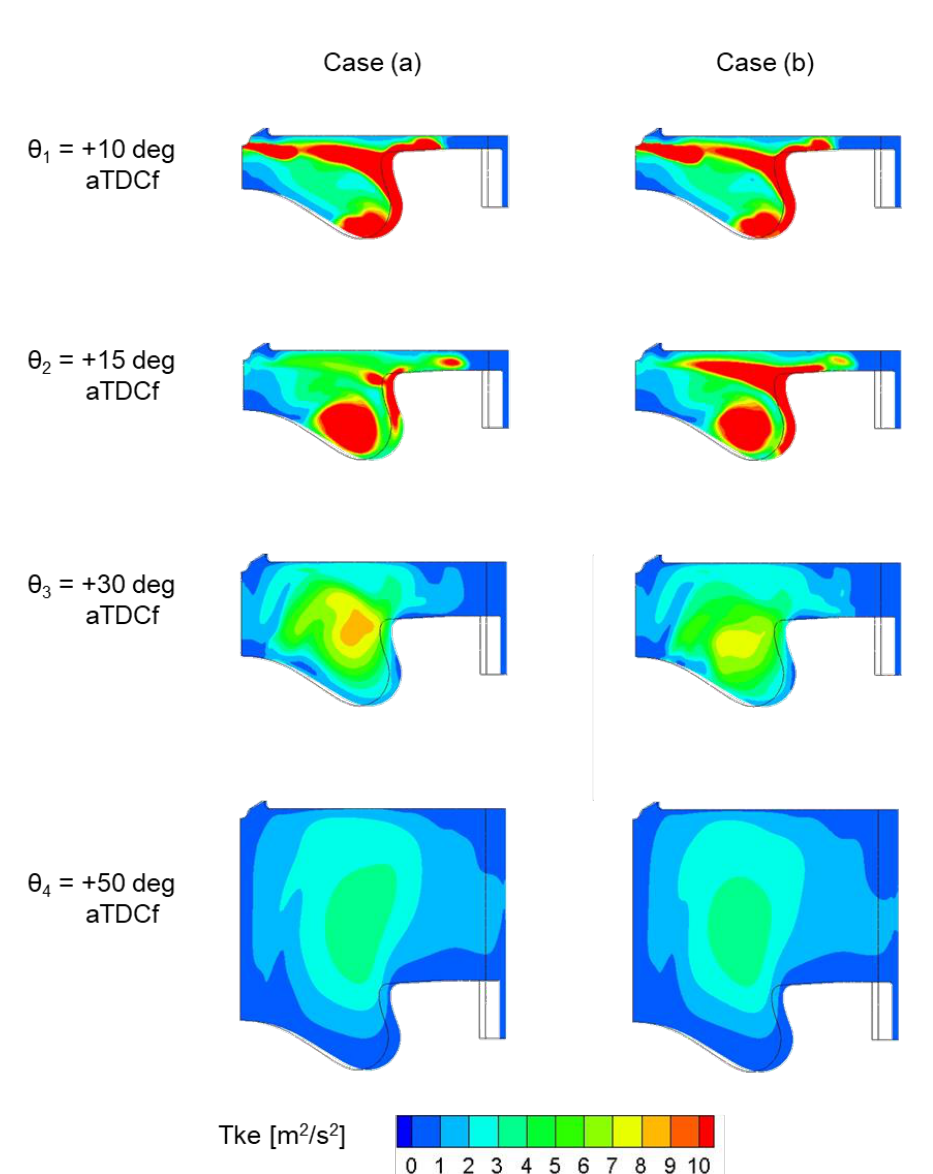
Figure 21. Contour plots of the Turbulent Kinetic Energy (TKE) distribution for the two chosen post injection schedules (case a and case b) at four different crank angle degrees.